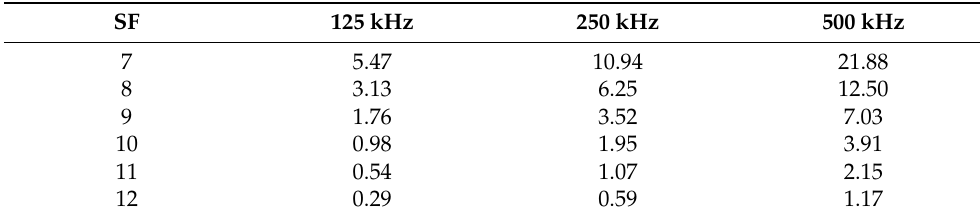
Table 6. Bit rate (kbits/s) for different ranges of SF and